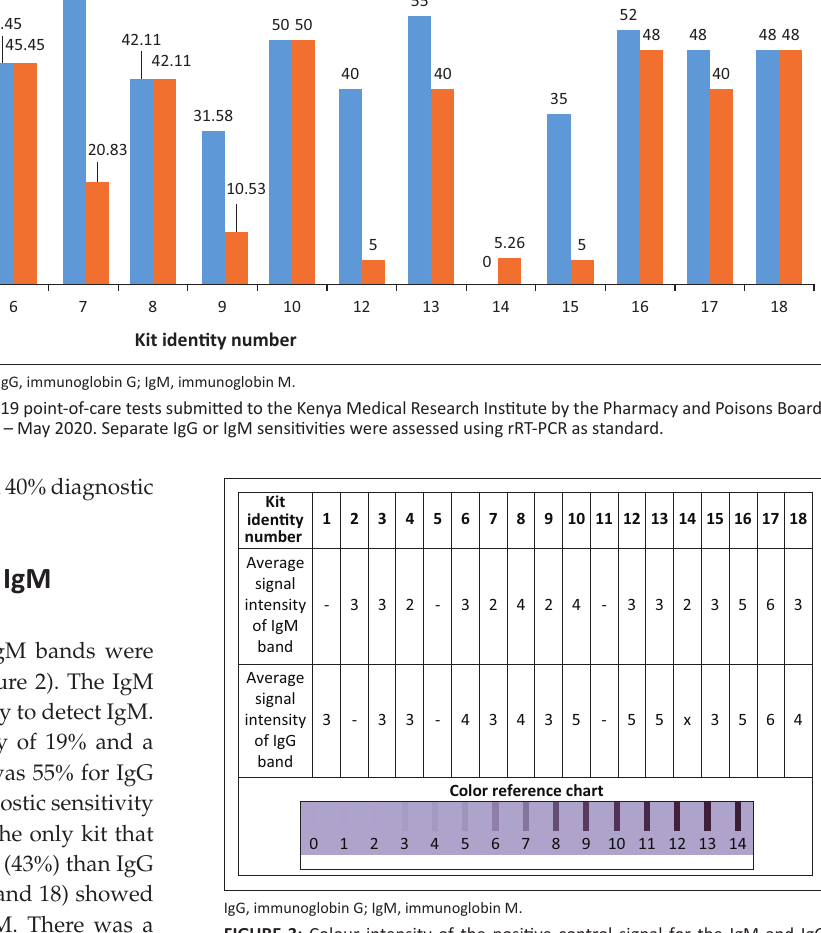
FIGURE 3: Colour intensity of the positive control signal for the IgM and IgG bands of point-of-care tests assessed at Kenya Medical Research